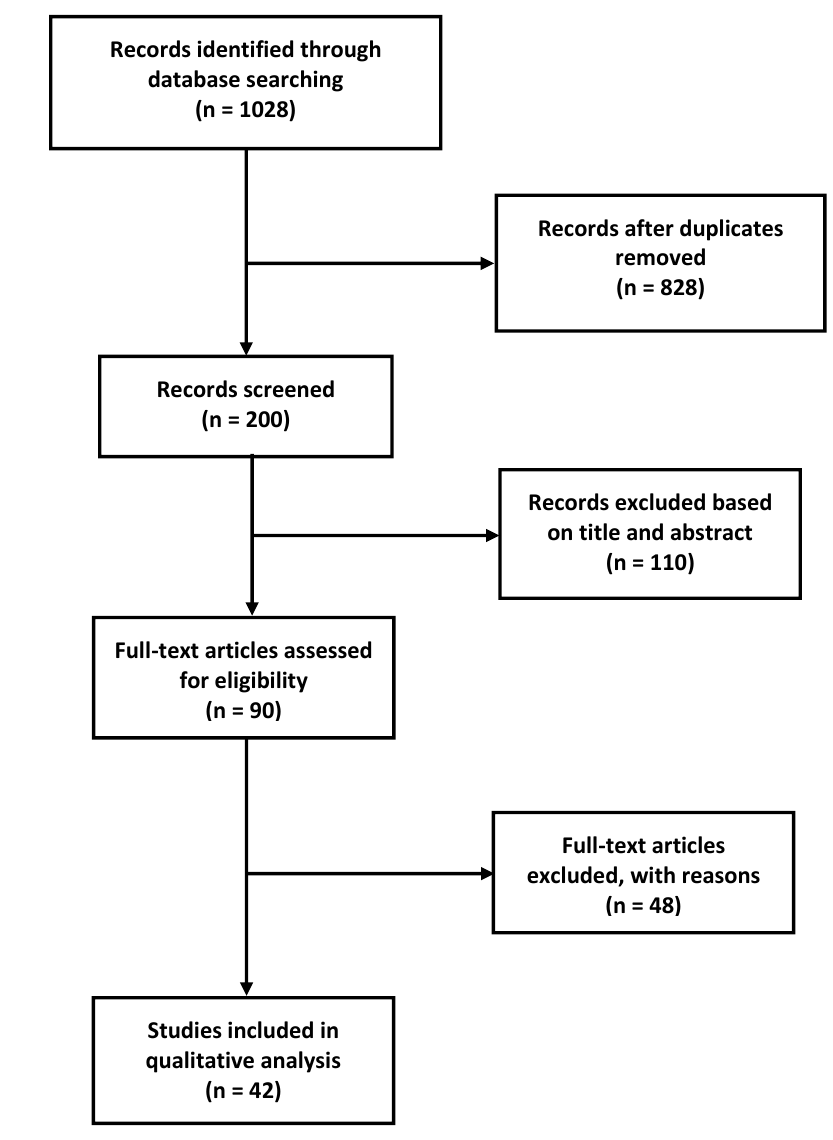
Figure 2. Search strategy for systematic review according to PRISMA guidelines [47].